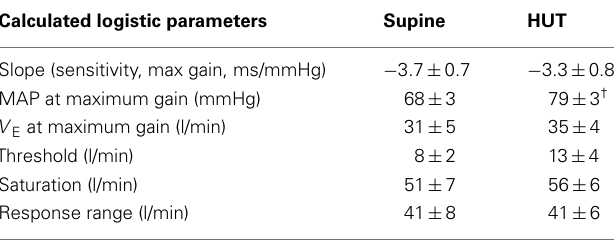
Table 4 | Calculated ventilatory baroreflex (slopes), threshold, saturation, and response range using the modified Oxford method.